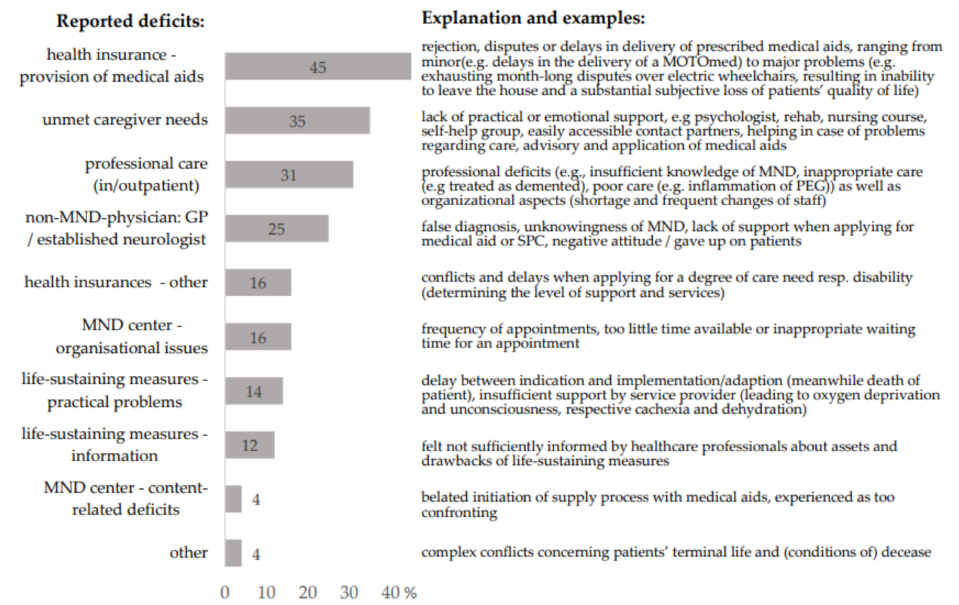
Figure 1. Deficits in socio-medical care reported by the caregivers. Multiple answers were possible. Data in percent. GP, general practitioner; MND, motoneuron